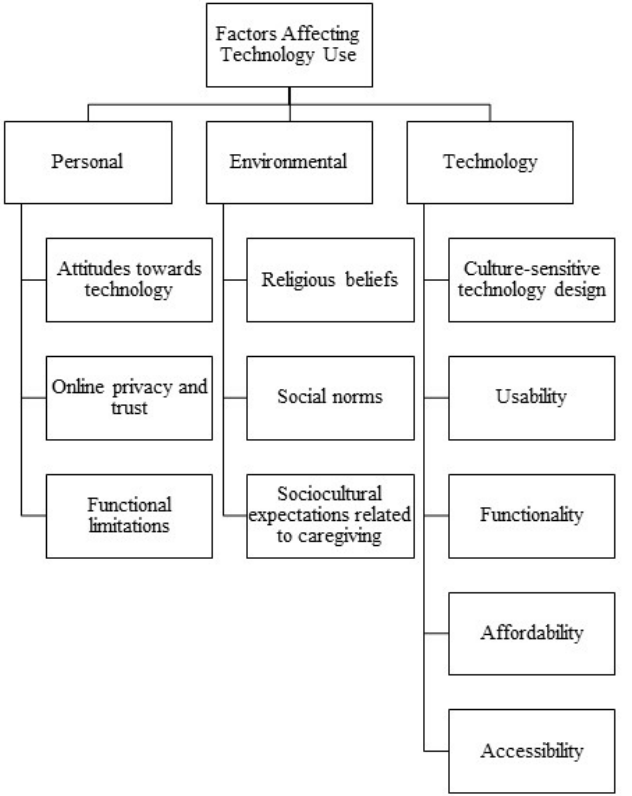
Figure 2. Overview of factors affecting technology use identified in the review.